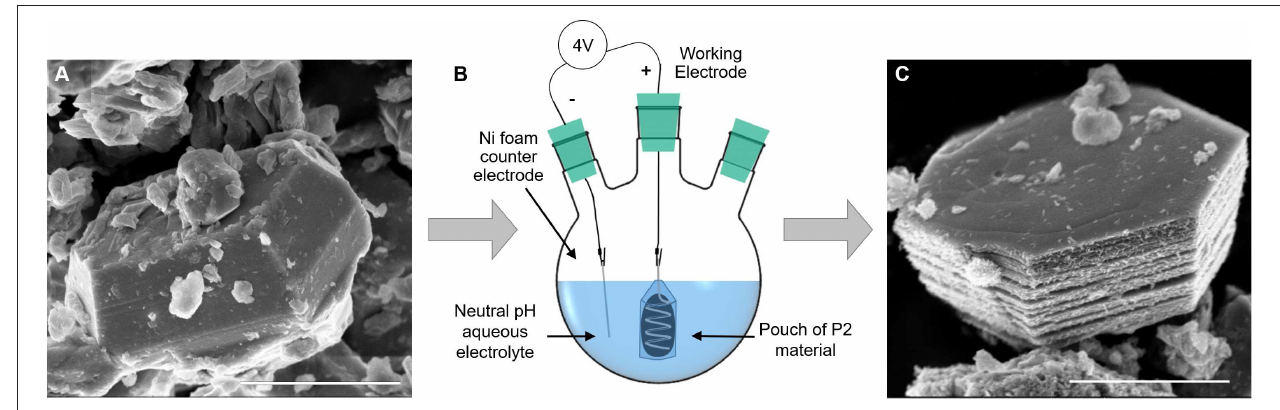
FIGURE 2 | Effect of batch expansion on particle morphology: (A) a pristine P2 NaMCu particle has a compact structure, which expands after electrochemical water insertion. (B) A schematic of the electrochemical expansion setup, where the P2 material is contained in a dialysis tubing pouch around a coil of Pt wire, and the counter electrode is Ni foam. (C) A typical fully expanded NaMCu particle, which retains its ab -plane morphology but expands vertically due to water insertion. Scale bar 2 µ